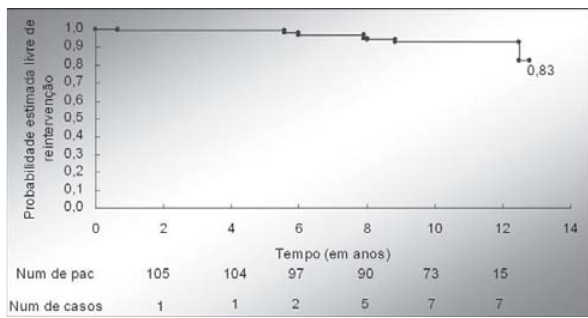
Fig. 1 – Probabilidade estimada de sobrevida